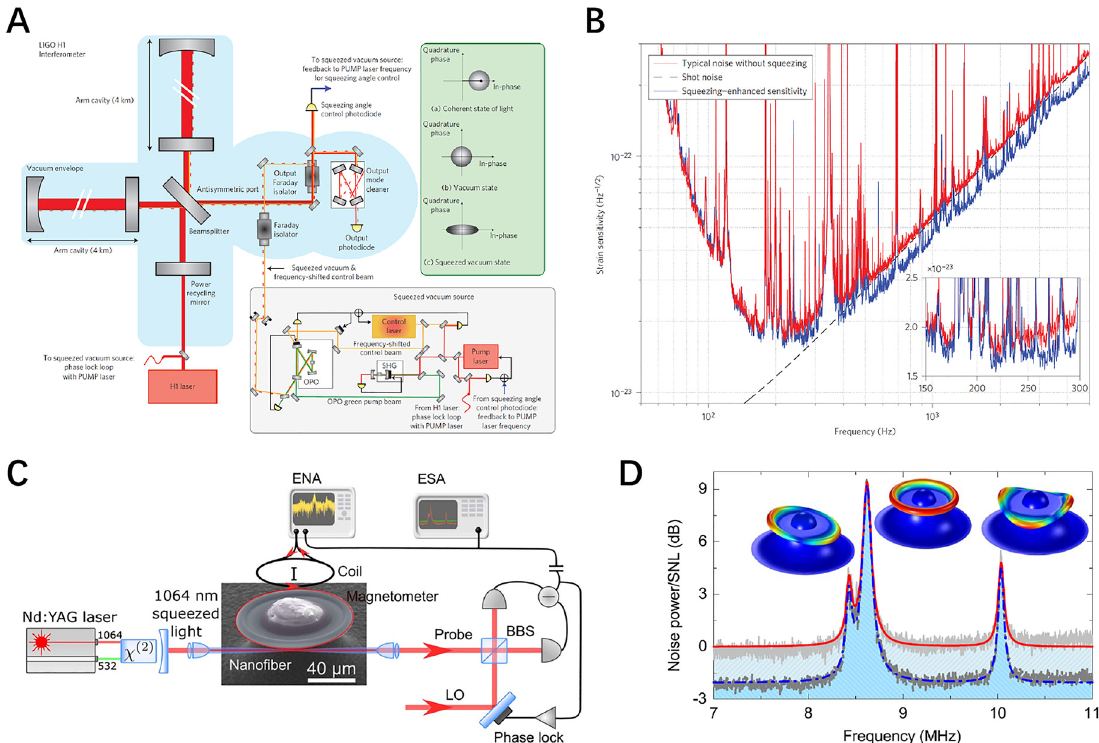
Figure 26: Squeezed light enhanced optomechanical sensing. (A), simplified layout of the interferometer with squeezed vacuum injection. (B) Noise suppression in the shot noise limited frequency band in LIGO with the injection of squeezed light [174]. (C) Measurement setup for the squeeze light enhanced cavity optomechanical magnetometry. (D) Noise power spectra of the cavity optomechanical magnetometry, with coherent probe (red curve) and squeezed probe (blue curve), showing a 2.5 dB noise suppression in the shot noise limited frequency band